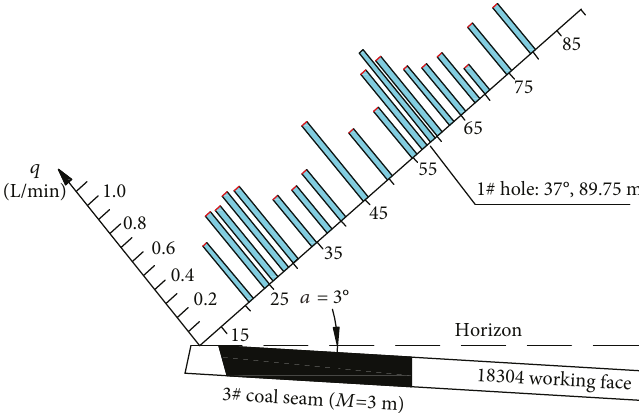
Figure 11: The amount of water leakage of 1# borehole (37 ° ) before